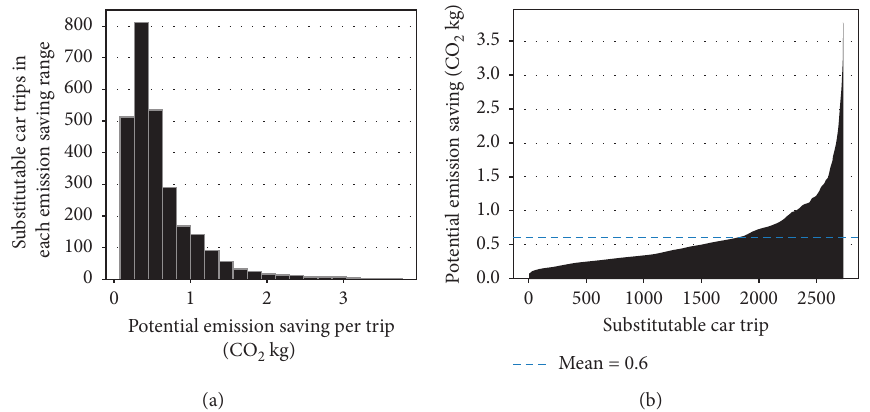
Figure 14: Size and distribution of potential emission savings among door-to-door car trips with alternatives.